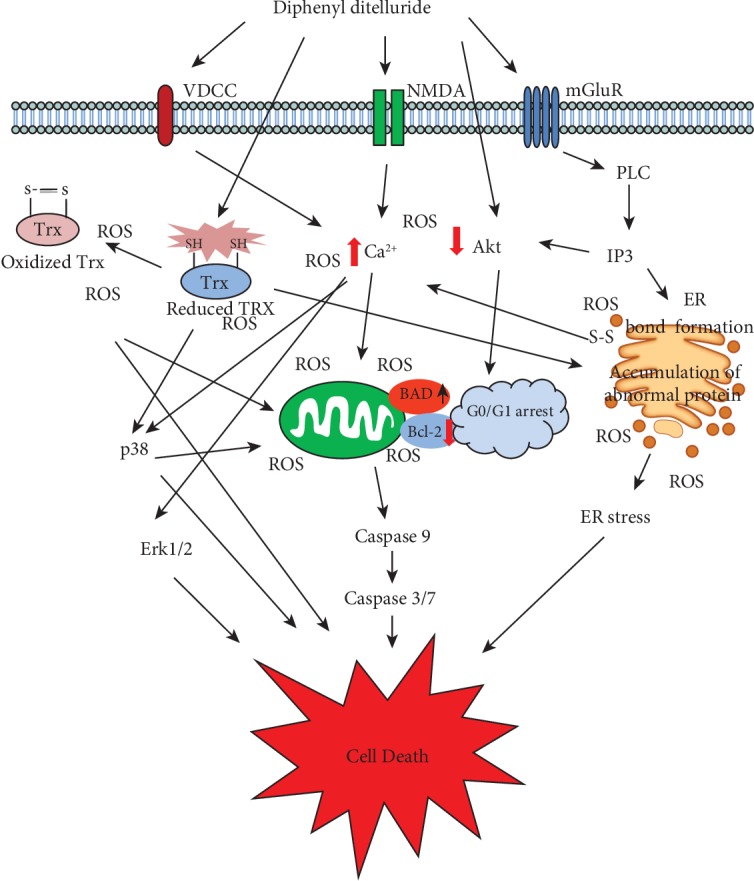
Mechanisms of diphenyl ditelluride antiproliferative action in cancer and noncancer cells. The high intracellular Ca2+ levels are correlated with an increase in Erk1/2 and p38MAPK phosphorylation. As a consequence, cellular redox imbalance and cell death were induced. DPDT, as a modulating agent of the cellular redox state, can interfere with the activity of different redox-active proteins (such as TRX), leading to redox imbalance and increasing their vulnerability to additional ROS-induced DNA damage and cell death. Also, DPDT can induce apoptosis and/necrosis by inducing as well as caspase activation. On the other hand, DPDT can induce cell death by decreasing Akt phosphorylation and activation of p38 and Erk1/2.